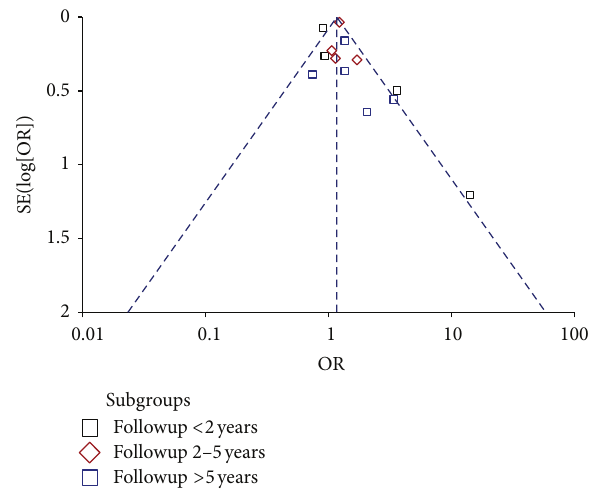
Figure 3: Funnel Plot. Egger’s test: bias = 0.68 ( − 0.53–1.90); 𝑃 = 0.241